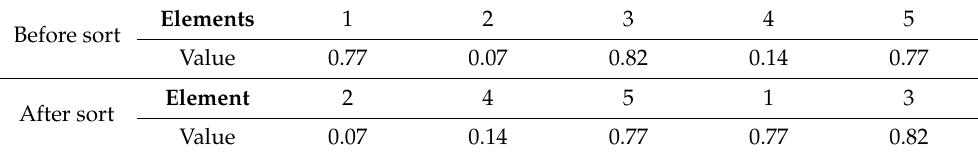
Table 4. Sorting results of the value of elements of track